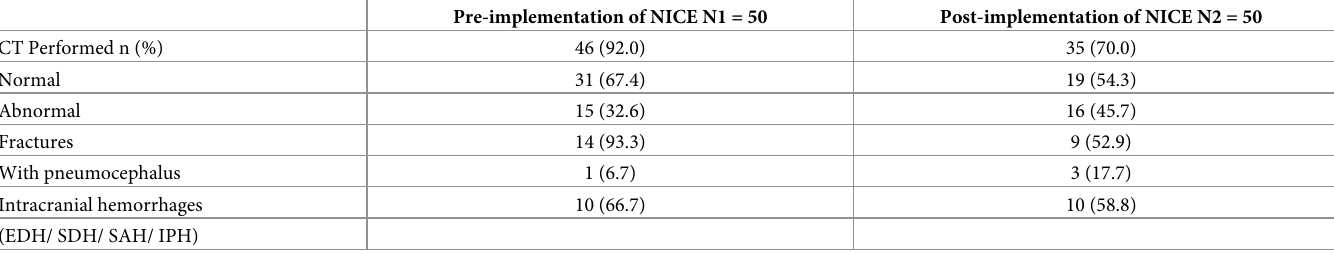
Table 4. Proportion of CT head scans and CT findings in the pre and post-implementation phases of the study, n = 100.